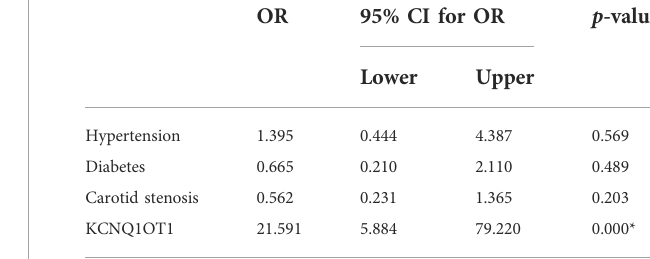
TABLE 2 Logistic regression analysis of independent risk